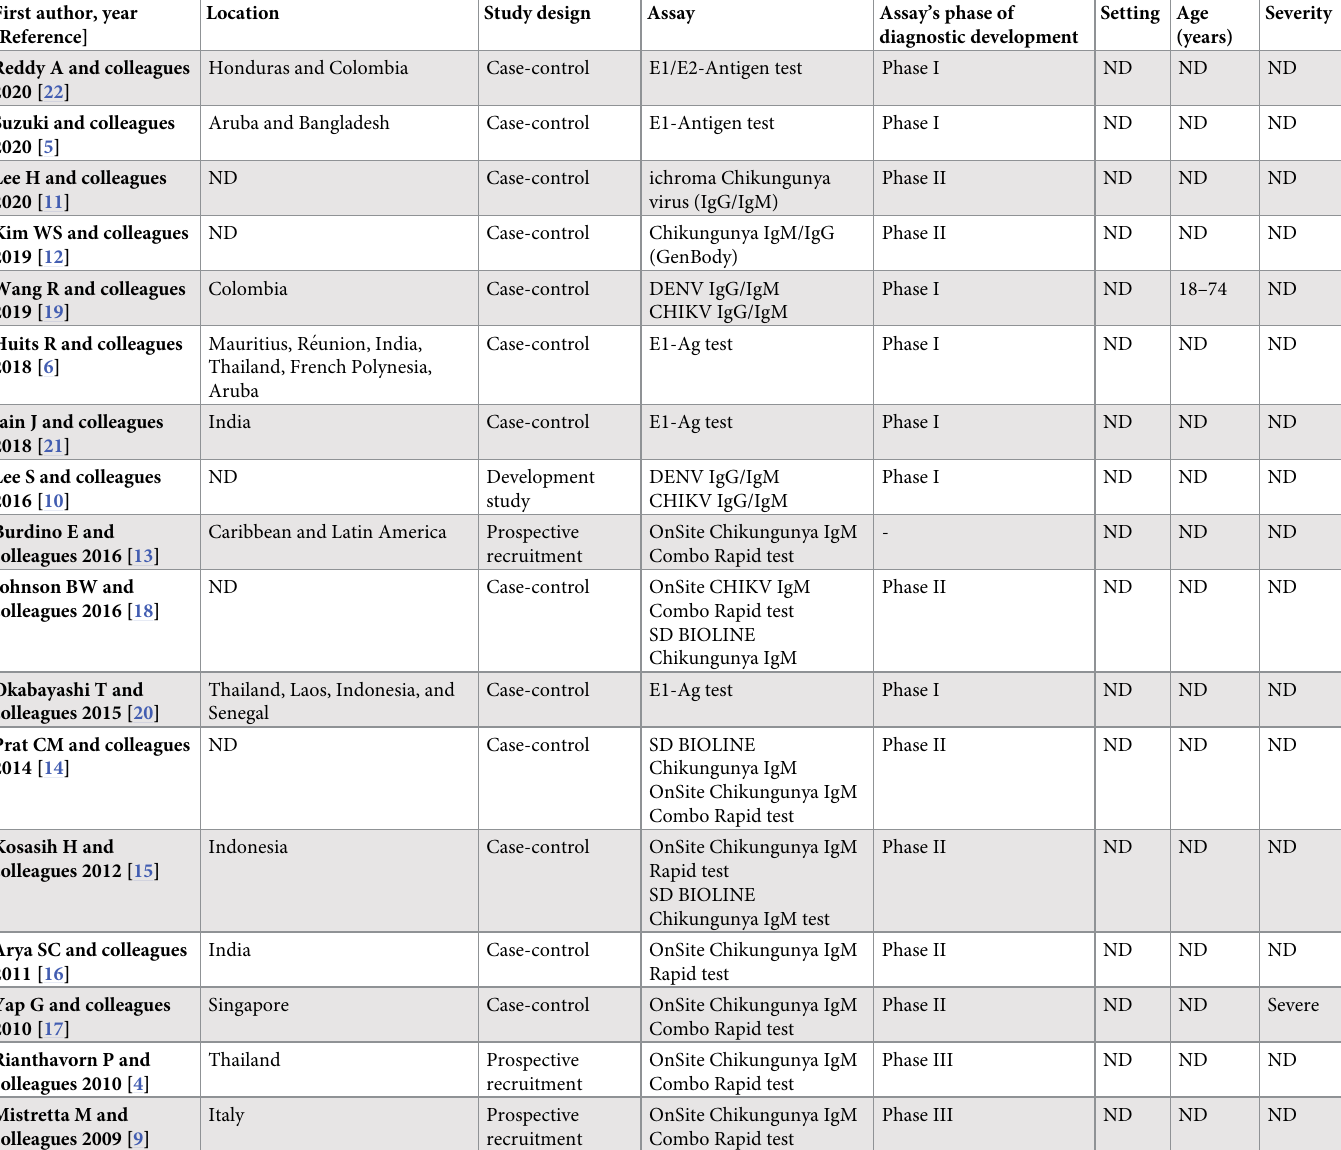
Table 1. Characteristics of included studies evaluating Chikungunya antibody or antigen-based rapid diagnostic tests,